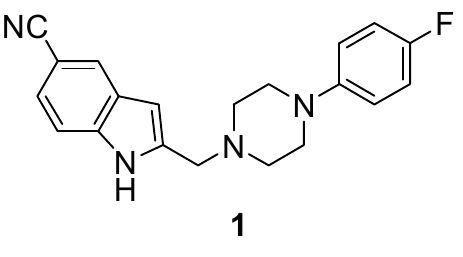
Figure 1. FAUC 316, one of the most selective ligands known for the D 4